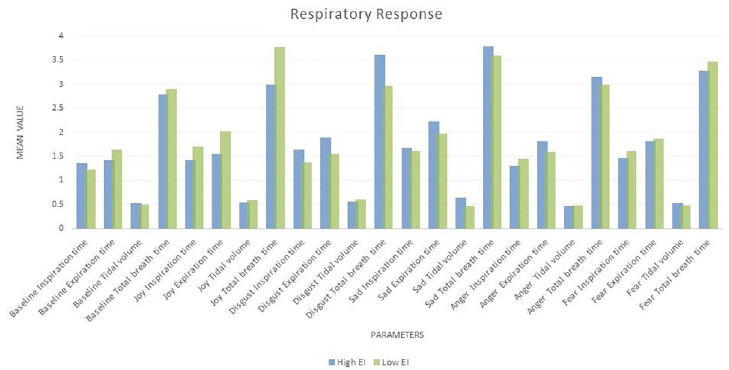
Fig 6. Mean respiratory response of high and low EI